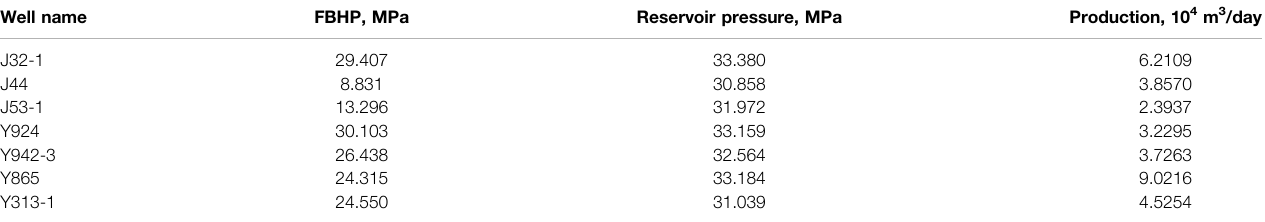
TABLE 4 | Data of stability test point of paleozoic gas reservoir in Jingbian sector of Yan ’ an gas fi eld.